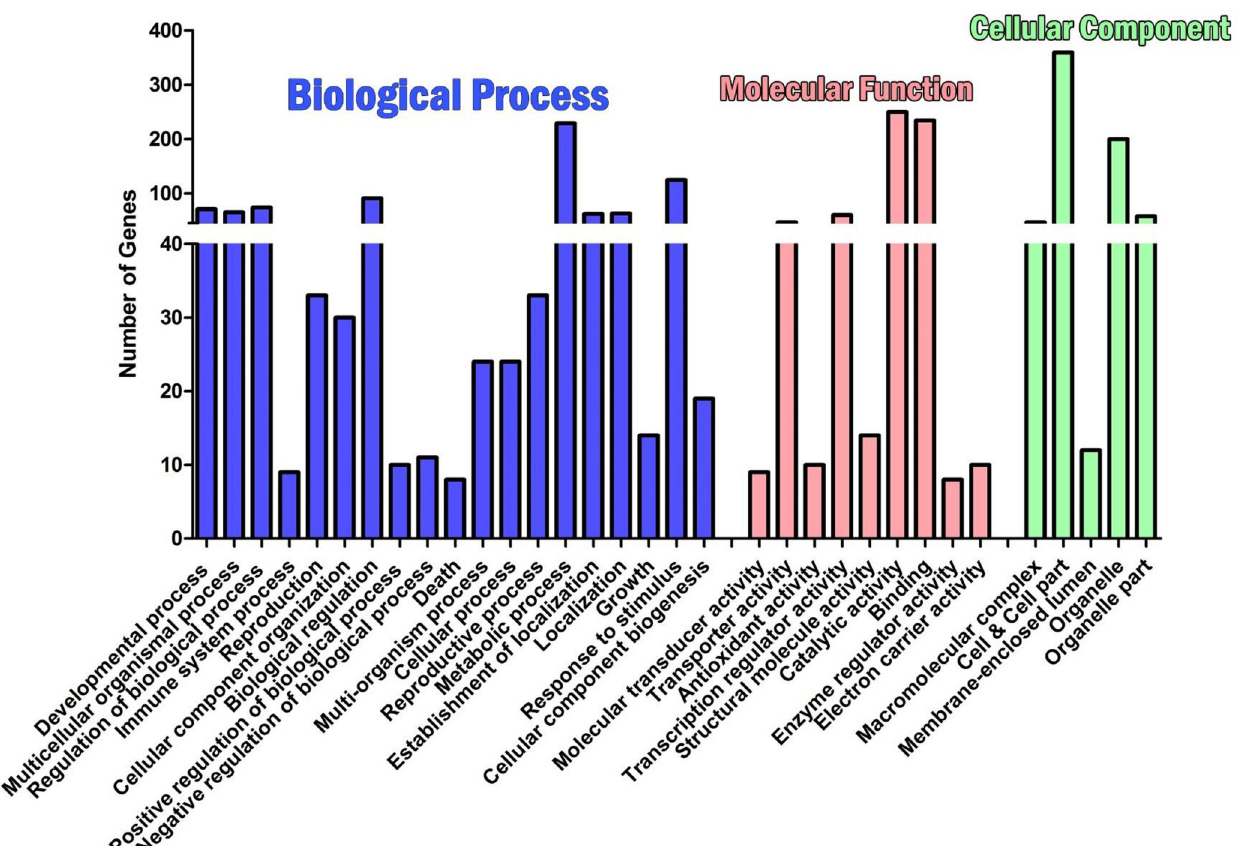
Fig 3. GO classification of non-redundantly expressed genes in CGMS, maintainer and restorer lines of Gossypium hirsutum L.